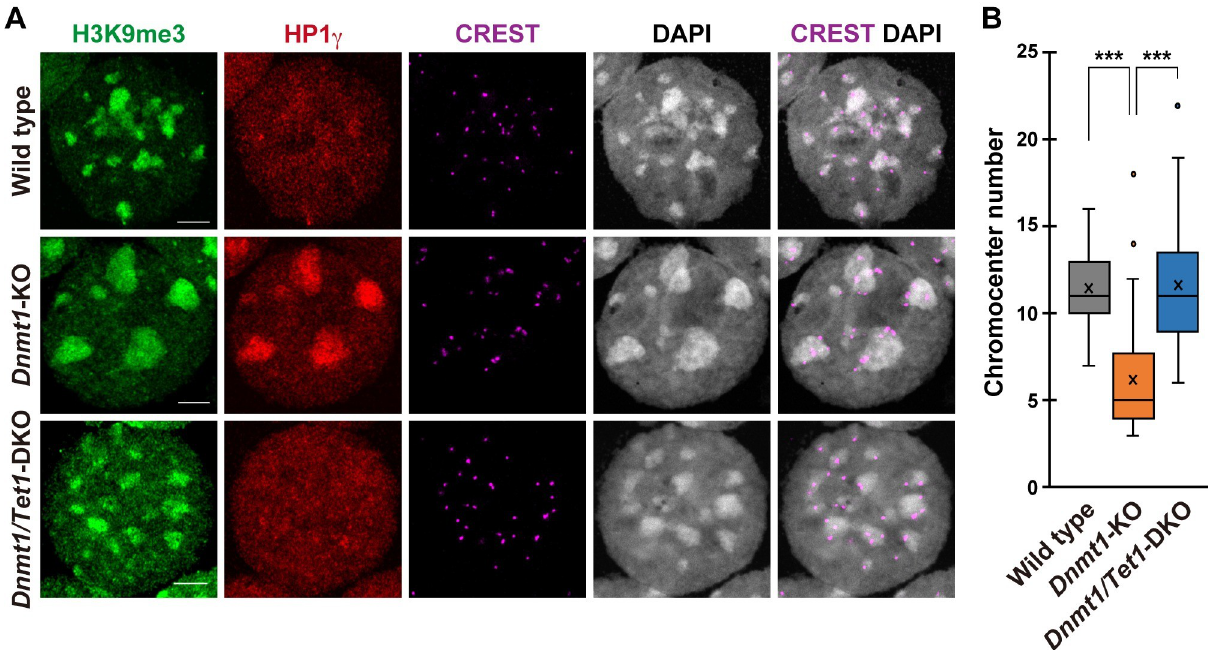
Fig 1. Tet1 -dependent chromocenter clustering in the DNA hypomethylated ESCs. (A) : Representative immunostaining images of the surface-spread nuclei of the wild-type, Dnmt1 -KO and Dnmt1/Tet1 -DKO ESCs. Scale bar, 5 μ m. (B) : Boxplot showing the number of distinct chromocenters in the nuclei of ESCs, related to (A). In boxplots, the enter lines show the medians; box limits indicate the 25th and 75th percentiles, and whiskers extend 1.5 times the interquartile range from the 25th and 75th percentiles. Actual values are indicated by circles. Wild-type, n = 55; Dnmt1 -KO, n = 64; Dnmt1/ Tet1 -DKO, n = 64. P values were calculated using the Mann-Whitney U-test. ��� P < 0.001.